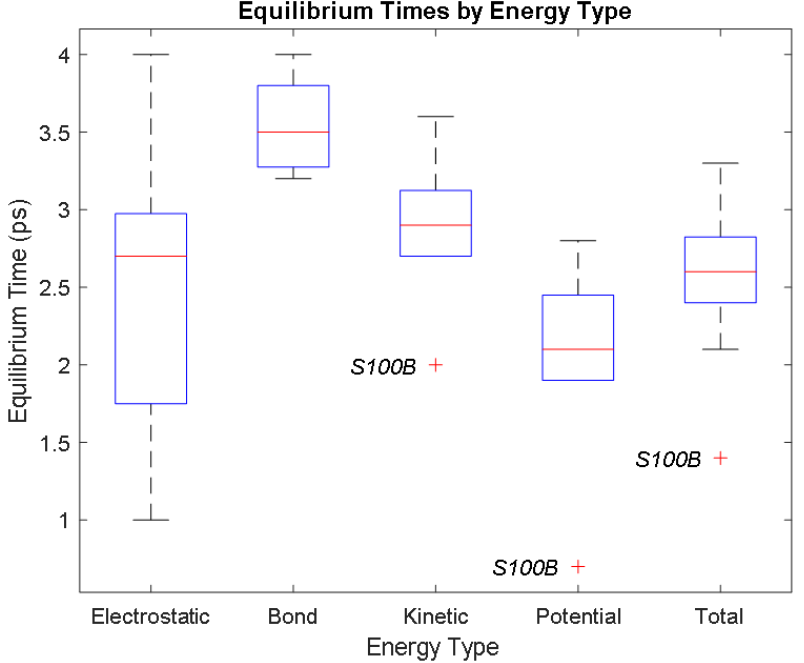
Figure 33. A box plot showing the spread of equilibrium times for each energy type. The outliers were labeled with the names of their corresponding biomarkers.